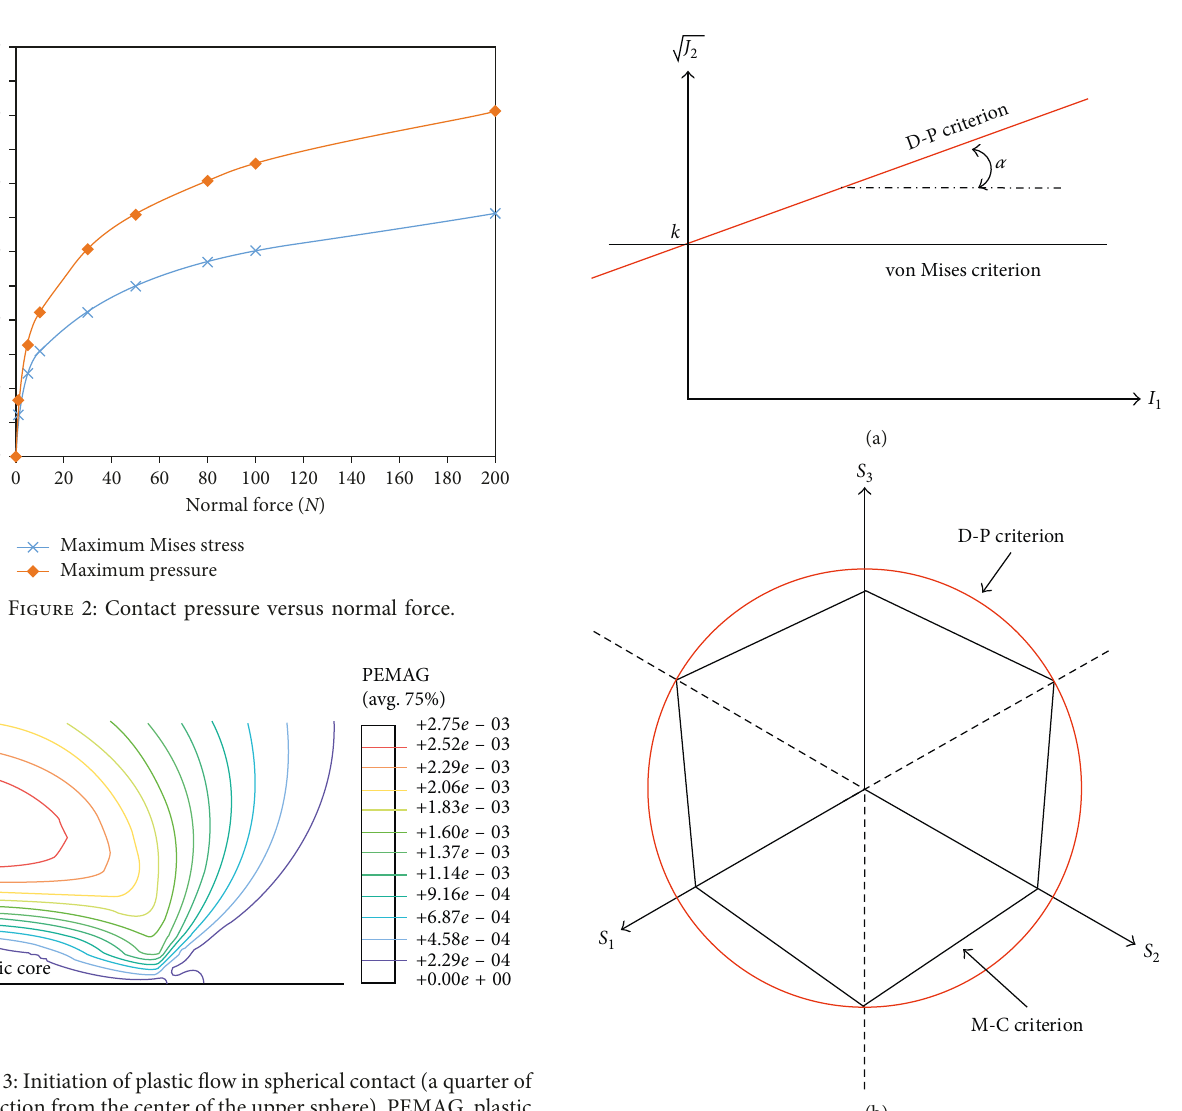
�� 􏽰 J − plane; (b) D-P versus M-C 1 2